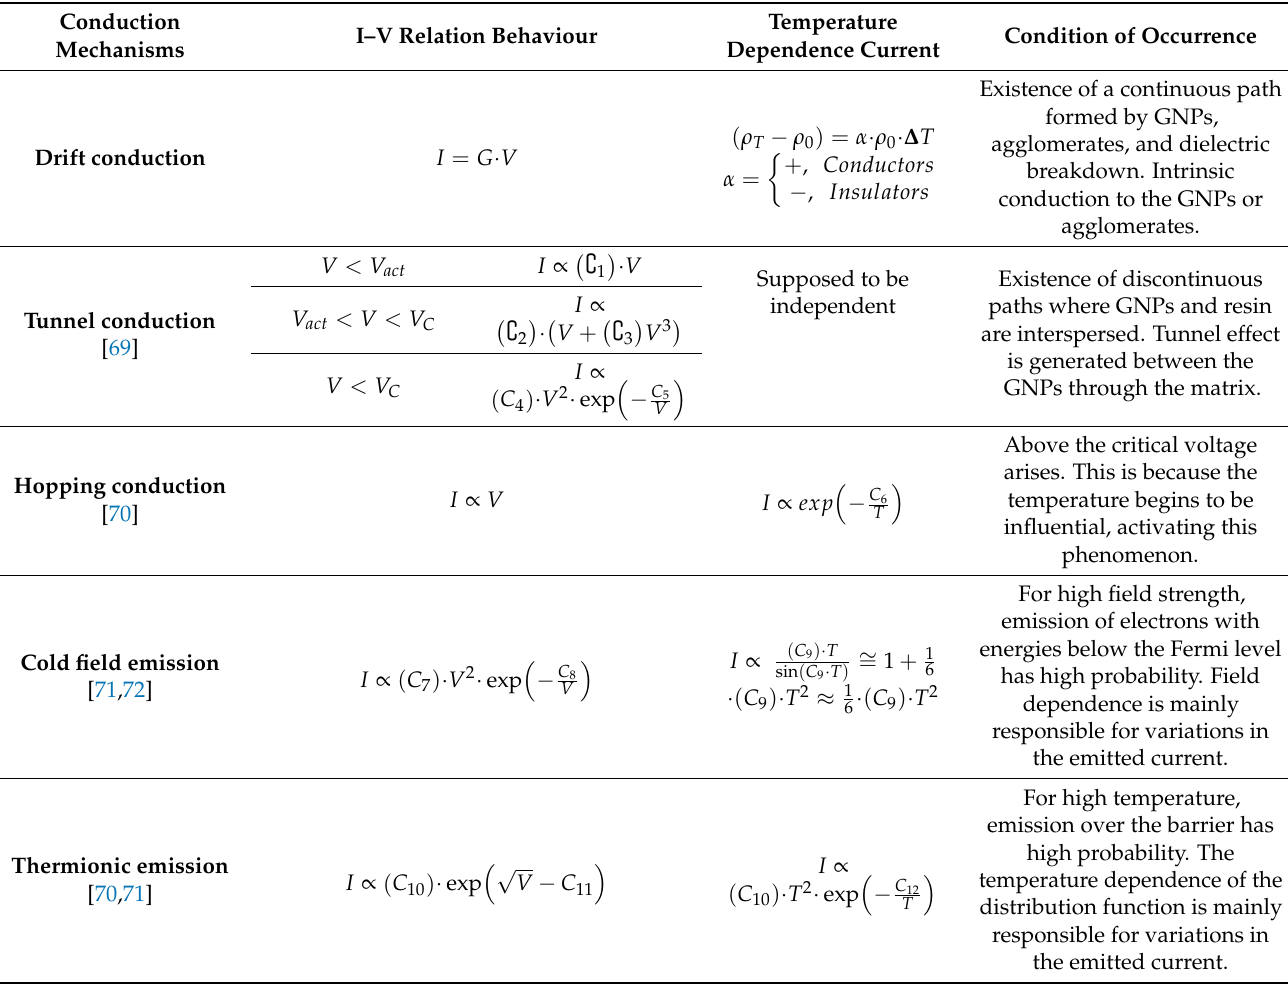
Table 2. Exposure of mechanisms involved in electrical conduction, and therefore in the Joule effect. For each mechanism the I–V relation, the dependence of conductivity on temperature, and the necessary conditions for the intervention of each mechanism are